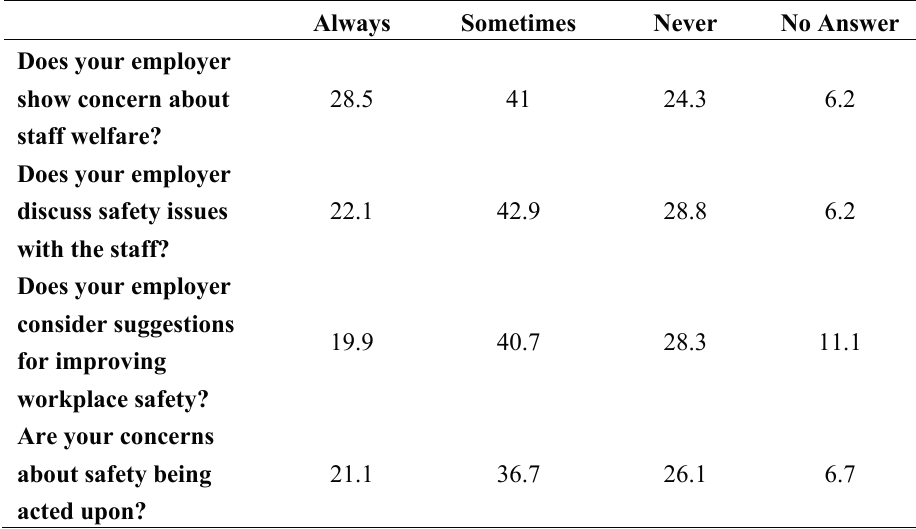
Table 5. Responses by miners concerning the attitude of their employers towards safety issues in artisanal and small-scale gold mining communities in the Tarkwa (Ghana) region. Values in the table are percentages. For the final question, 9.4% indicated not having any